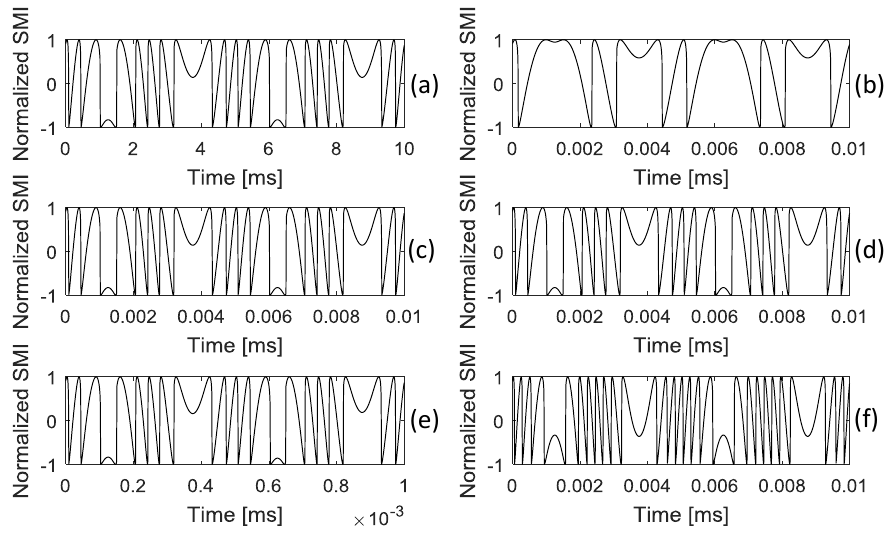
Figure 2. Responses of the FBG–SMI system to strains with different frequencies and amplitudes, ( a , c , e ) show the normalized SMI signals for a dynamic strain with 20.7 με magnitude respectively at frequency of 200 Hz, 200 KHz, and 2 MHz; ( b , d , f ) show the normalized SMI signals for a dynamic strain at 200 KHz but with the magnitudes as 10.3 με, 20.7 με, and 31.0 με respectively.